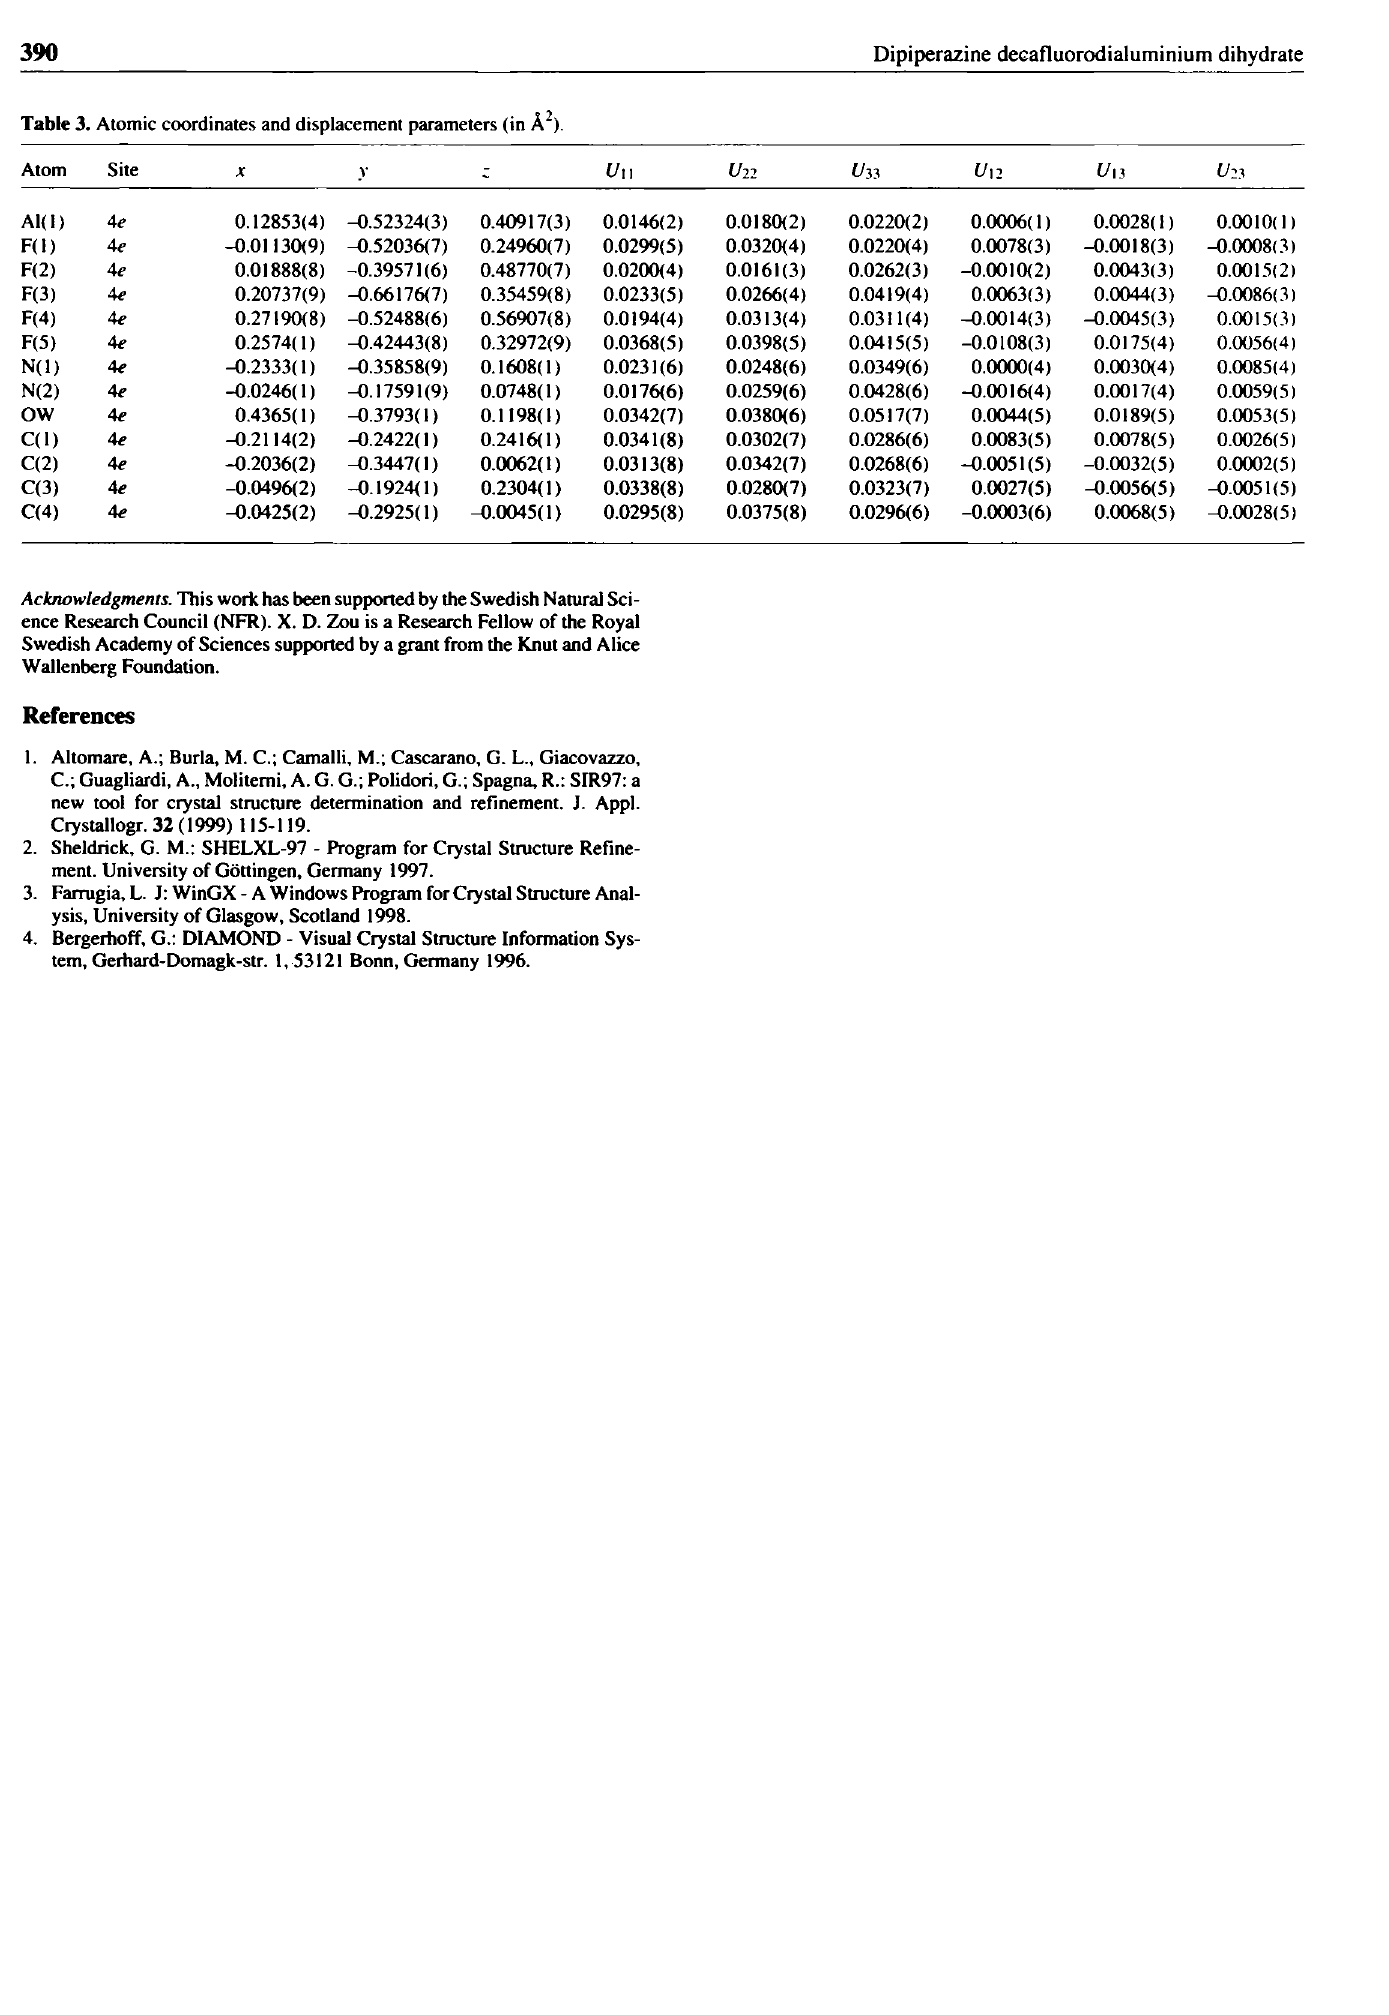
Table 3. Atomic coordinates and displacement parameters (in A 2